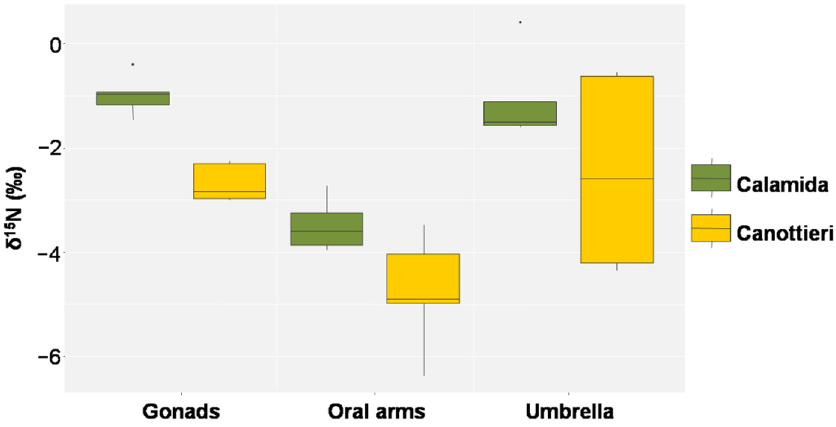
Figure 11. Box plot of δ 15 N in the gonads, oral arms, and umbrella of Cassiopea andromeda individuals